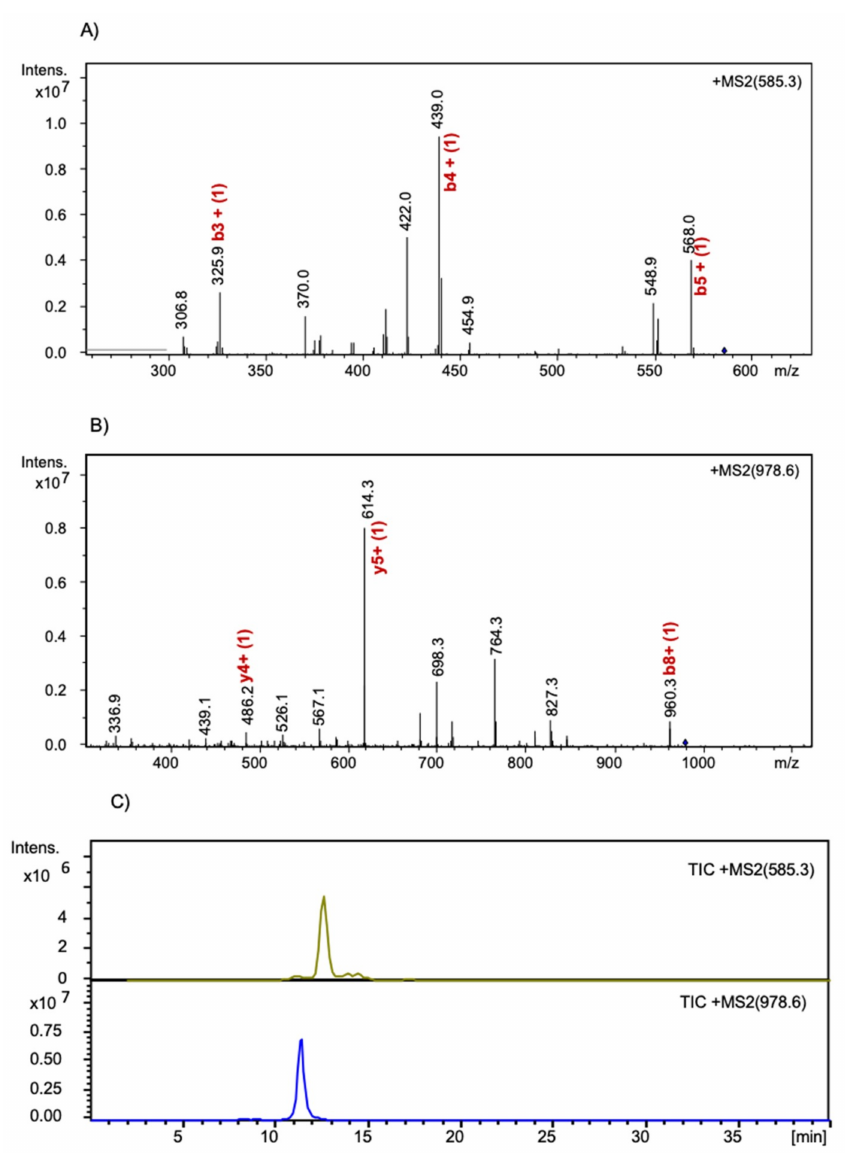
Figure 4. Electrospray ionization-tandem mass spectrometry spectra of [M + H] + ions of ( A ) PNNIQ and ( B ) NIHKRTPL, respectively; ( C ) Total ion chromatograms (TIC) of PNNIQ ( m / z 585.23) and NIHKRTPL ( m / z